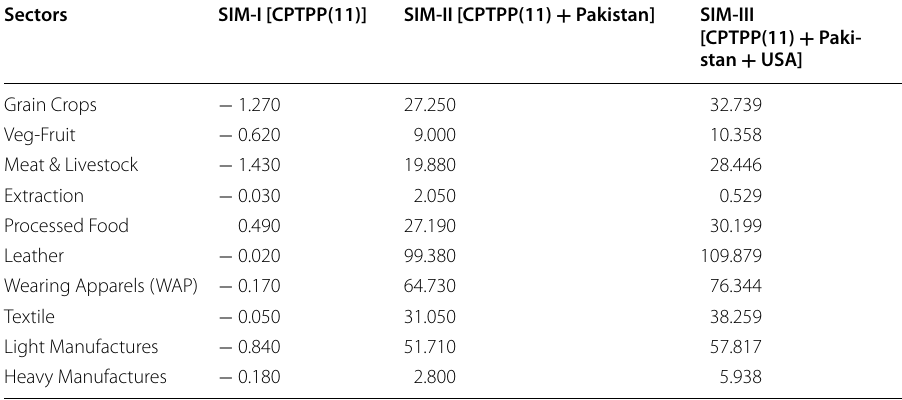
Table 6 Impact of CPTPP on sectorial imports of Pakistan Source : Author’s simulation